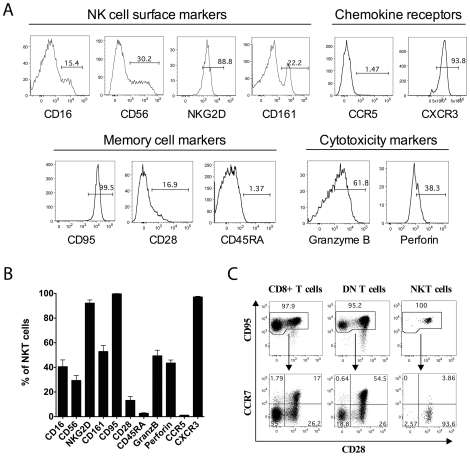
Phenotypic characterization of sooty mangabey NKT clones.A) Histogram plots gated on representative NKT clones showing surface expression of NK cell markers (CD16, CD56, NKG2D, and CD161), chemokine receptors (CCR5 and CXCR3), and memory markers (CD95, CD28, and CD45RA), and intracellular expression of cytolytic molecules (granzyme B and perforin). B) Mean % for each phenotypic marker on 5 to 71 NKT clones. Error bars denote standard error of mean (SEM). C) Memory phenotype of NKT lymphocytes in comparison to CD8+ and DN T lymphocytes in the peripheral blood of one SIV-negative sooty mangabey. Dot plots showing CD95 vs CD28 staining on each subset of T lymphocytes (top panel) and distribution of CCR7 and CD28 on the CD95+ memory lymphocytes (bottom panel).